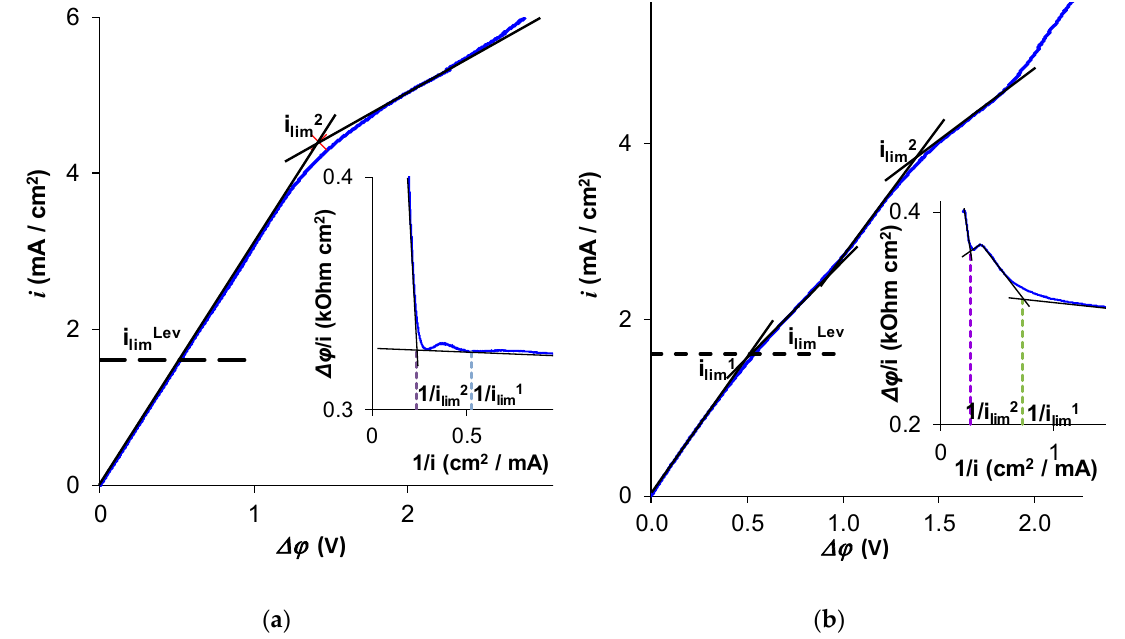
Figure 5. Current–voltage characteristics presented in the usual coordinates and the coordinates proposed by Cowan and Brown [43] (the insertion) for an AMX ( a ) and AEM Type X ( b ) membranes. i lim1 and i lim2 were the first and the second limiting currents determined by the tangent intersection method. The dashed lines in the insertions show the positions of the 1 / i lim1 and 1 / i lim2 points on the Cowan–Brown curves. The experiments were carried out in a 0.02 M NaH 2 PO 4